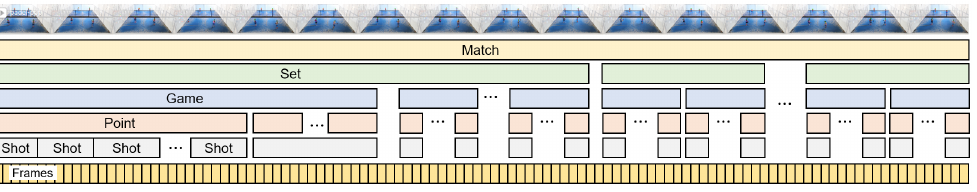
Figure 3. Hierarchy of temporal play units in a padel